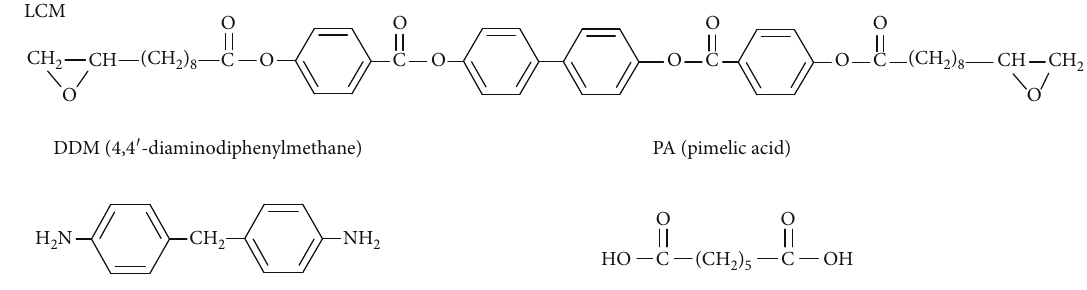
Figure 1: Molecular structure of the epoxy monomer and the curing agents. Table 1: Temperatures of phase transitions in the pure liquid crystal epoxy